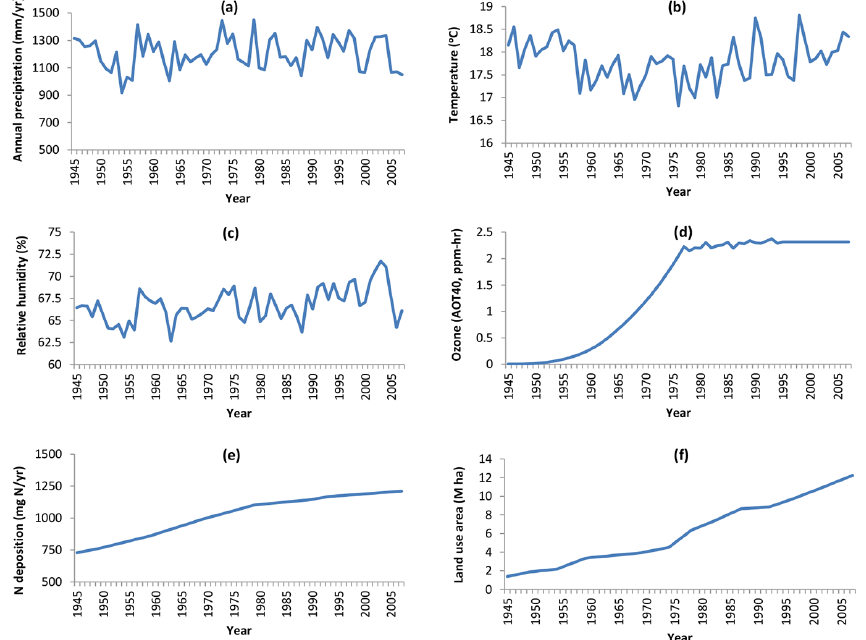
Figure 2. Temporal patterns of major global change factors in the study region from 1945 to 2007. (a) Annual precipitation; (b) temperature; (c) relative humidity; (d) ambient ozone exposure; AOT40 is the accumulated dose over a threshold of 40ppb during daylight hours in a month (Felzer et al., 2004); (e) annual nitrogen deposition rate; (f) urban land